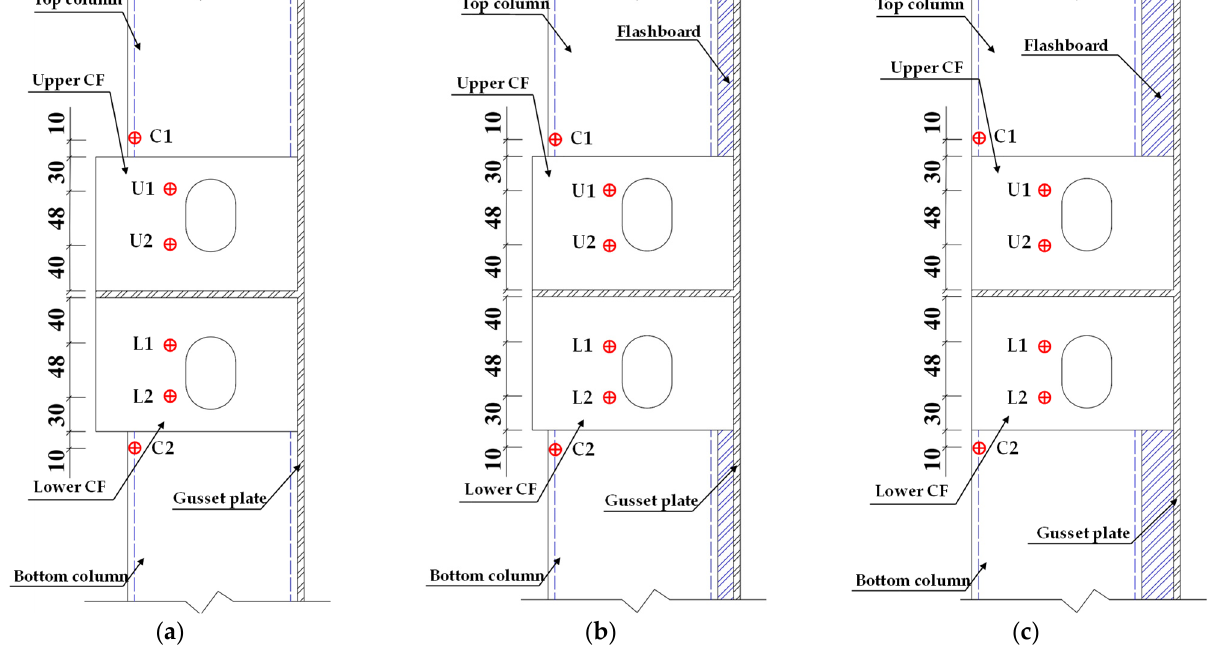
Figure 19. Reference points and column location: ( a ) reference points of original column location; ( b ) reference points of column location in middle of the corner fitting; and ( c ) reference points of column location in corner of the corner fitting.